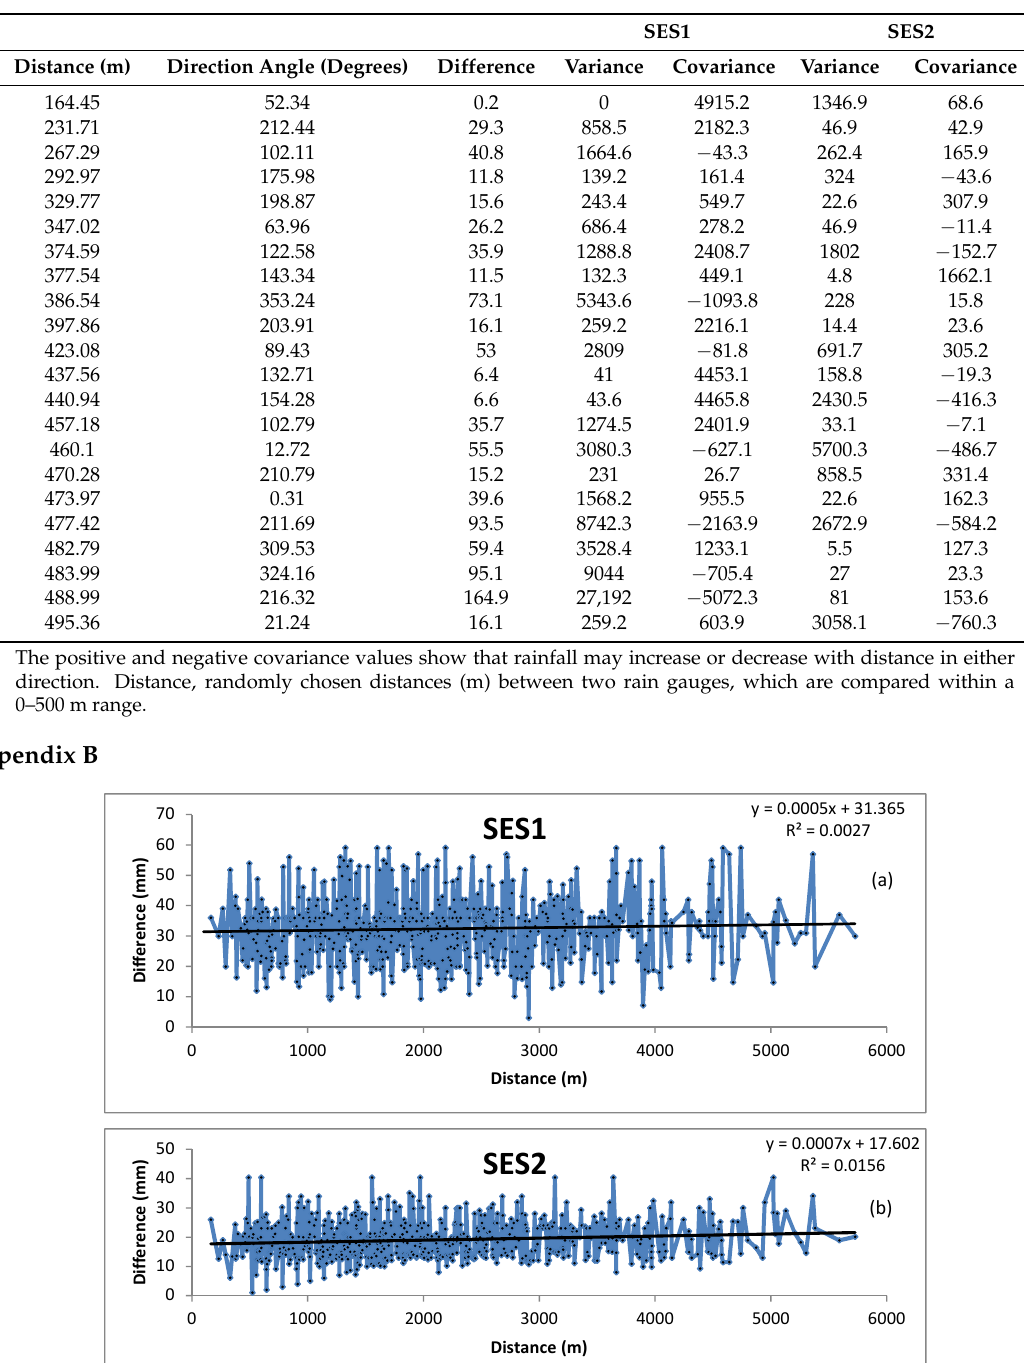
Table A1. Variogram cloud analysis from QGIS for annual rainfall variance in SES2.